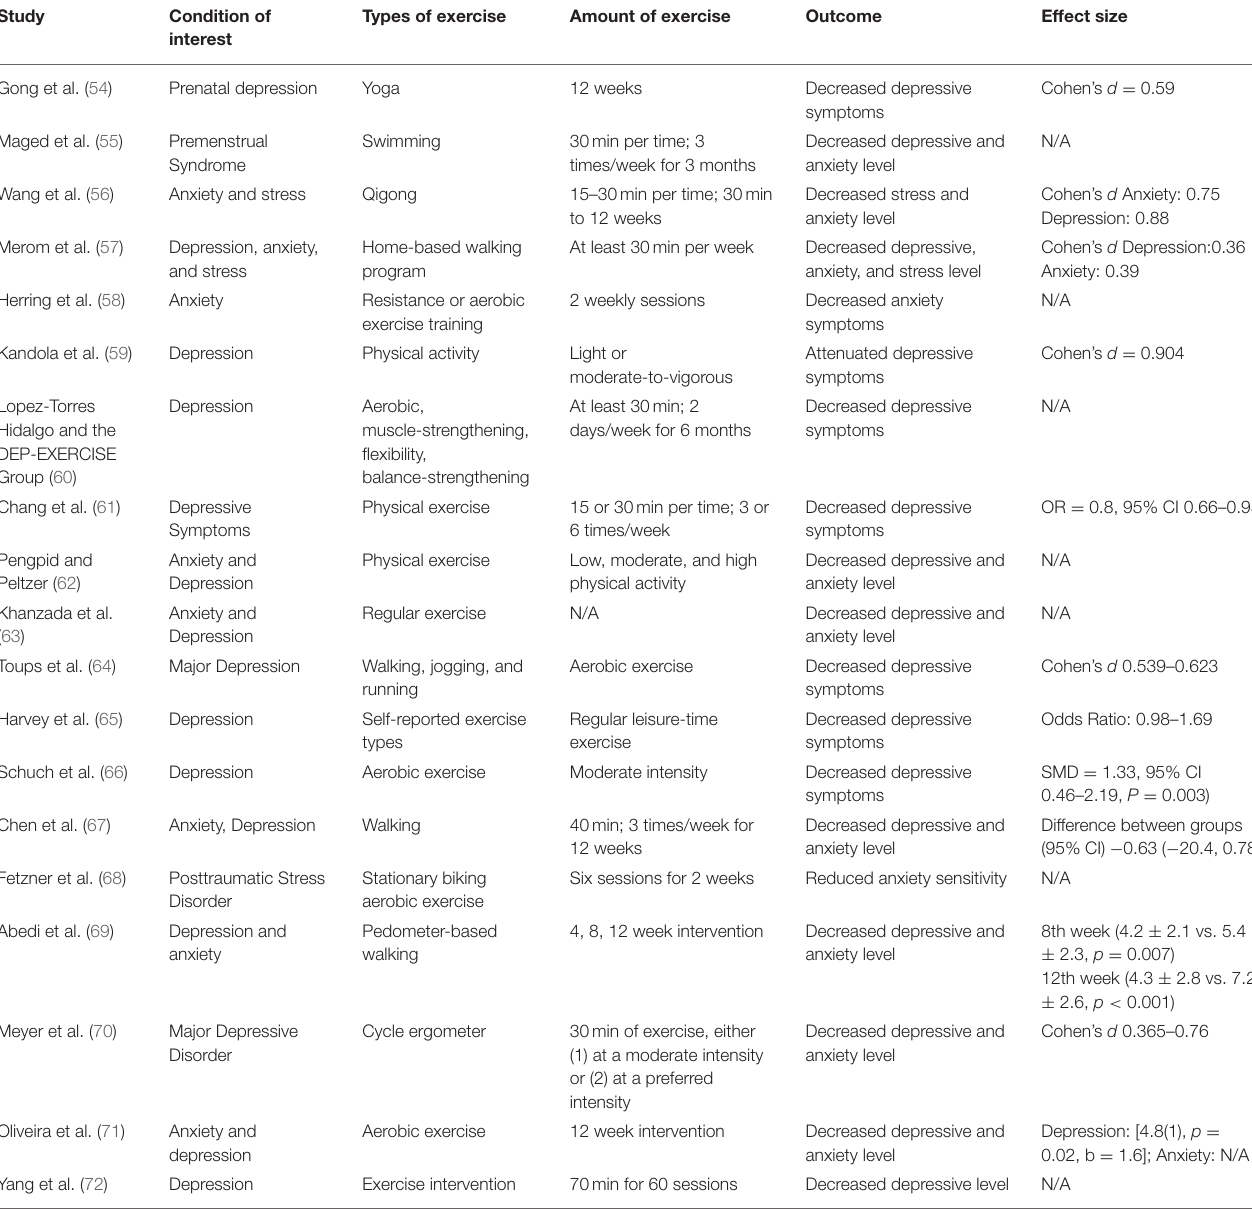
TABLE 2 | Summary of the effect of exercise on anxiety and depression in human studies.